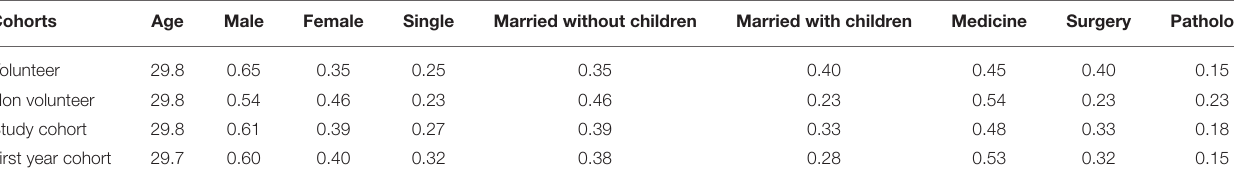
TABLE 1 | Demographics and specialty distribution among volunteers, non-volunteers, the study cohort, and responders from the first year cohort were similar and had no significant differences. Cohorts Age Male Female Single Married without children Married with children Medicine Surgery Pathology Volunteer